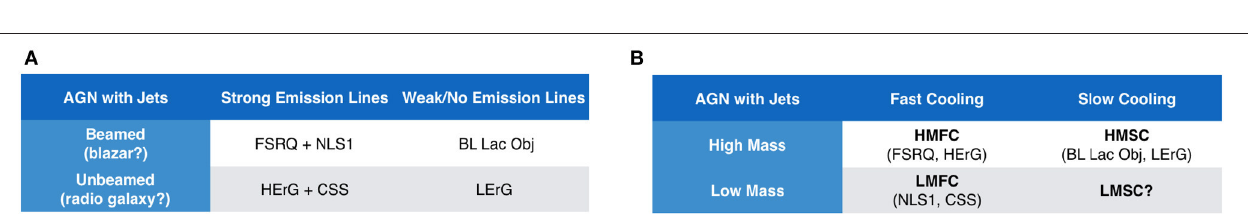
FIGURE 1 | Implications of the unification of relativistic jets. The AGN sample includes FSRQs (red circles), BL Lac Objects (blue squares or arrows for upper limits in disk luminosity), and NLS1s (orange stars). The XRB sample includes different states of some stellar-mass black holes (yellow triangles) and accreting neutron stars (magenta asterisks). HLX-1 is the only known jetted ultraluminous X-ray source with a reliable intermediate-mass black hole. See Foschini (2014) and references therein for details. (A) Different branches, different mechanisms. (B) Cosmological evolution.